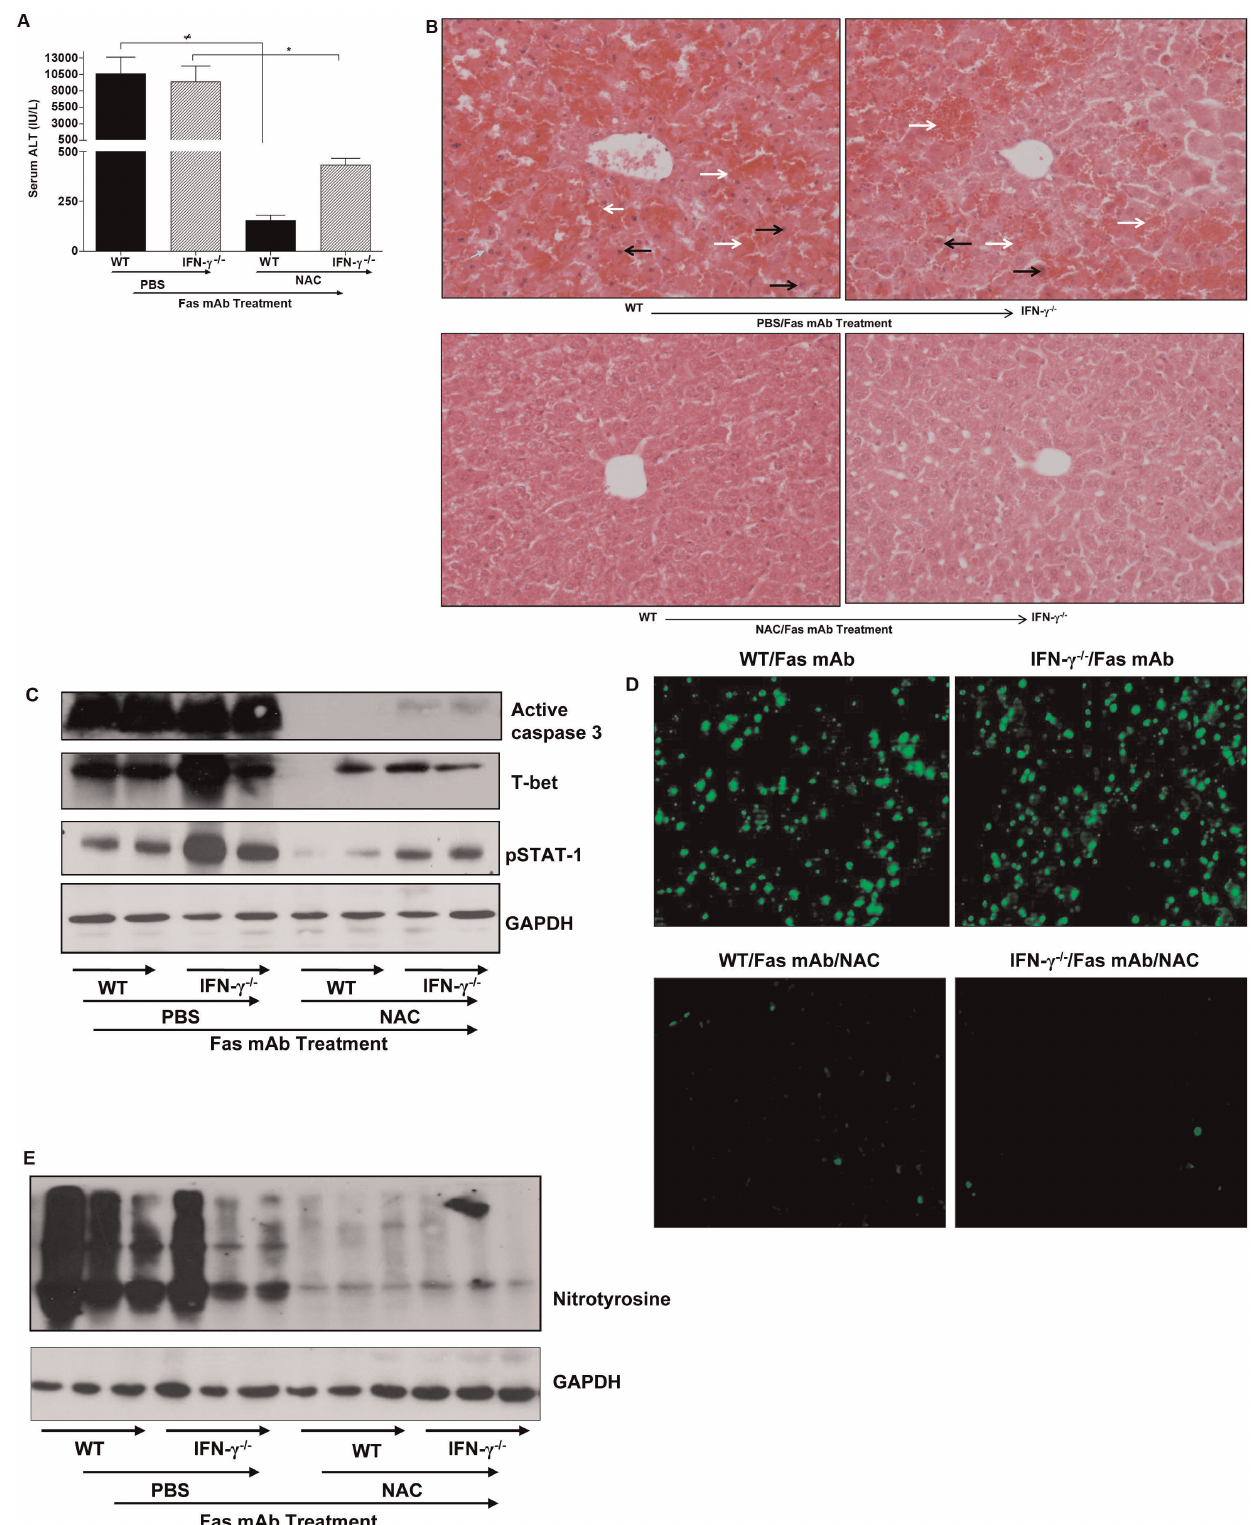
Figure 3. NAC therapy ameliorates agonistic Fas mAb-induced FLF during IFN- c deficiency. ( a ) Serum ALT levels in WT and IFN- c 2 / 2 mice after PBS or NAC treatment during agonistic Fas mAb-induced FLF. ( b ) H & E staining of liver sections of WT and IFN- c 2 / 2 mice after PBS or NAC treatment during agonistic Fas mAb-induced FLF. As shown in top panel , livers from Fas mAb-treated WT and IFN- c 2 / 2 mice displayed widespread hepatocyte damage including hemorrhagic necrosis (white arrows) and apoptosis (black arrows) that distorted normal liver architecture. In contrast, liver sections of WT and IFN- c 2 / 2 mice treated with NAC during Fas mAb-induced FLF ( bottom panel ) showed reduced hepatocyte damage and